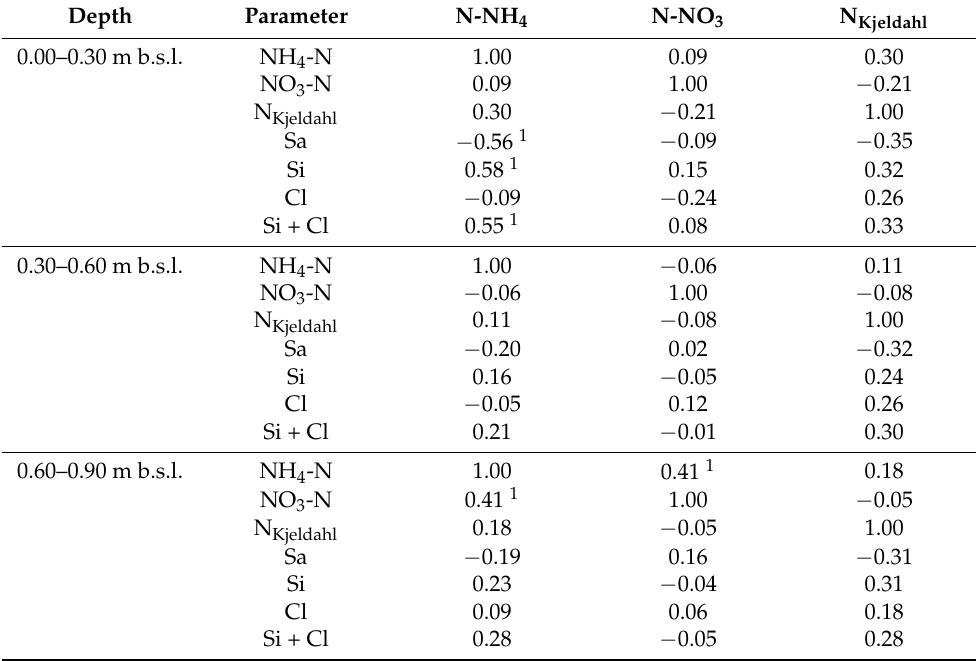
Table 7. Spearman correlation between the content of N forms and soil fractions at different depths; after variable fertilization